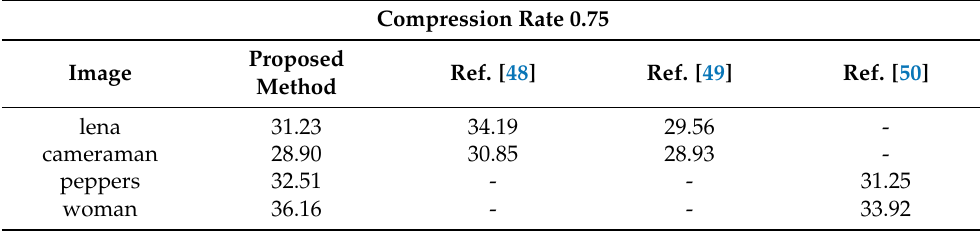
Figure 11. The first column shows the original images named lena, cameraman, peppers, and woman, respectively. The second, fourth, and sixth columns show the reconstructed images obtained by restricted-authorized receivers under compression rates 0.75, 0.5, and 0.25, respectively. The third, fifth, and seventh columns show the reconstructed images obtained by full-authorized receivers under compression rates 0.75, 0.5, and 0.25, respectively. Table 10. Compression performance comparison via PSNR values (Unit: